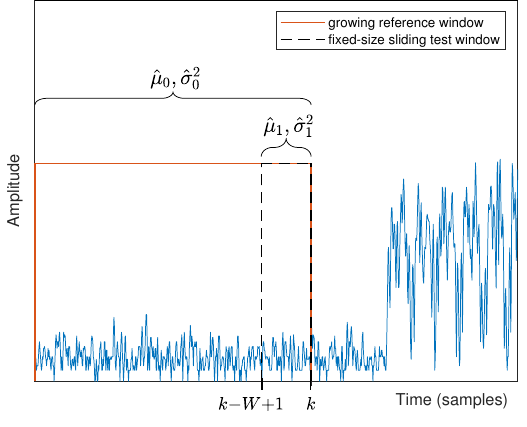
Figure 3. Reference and test